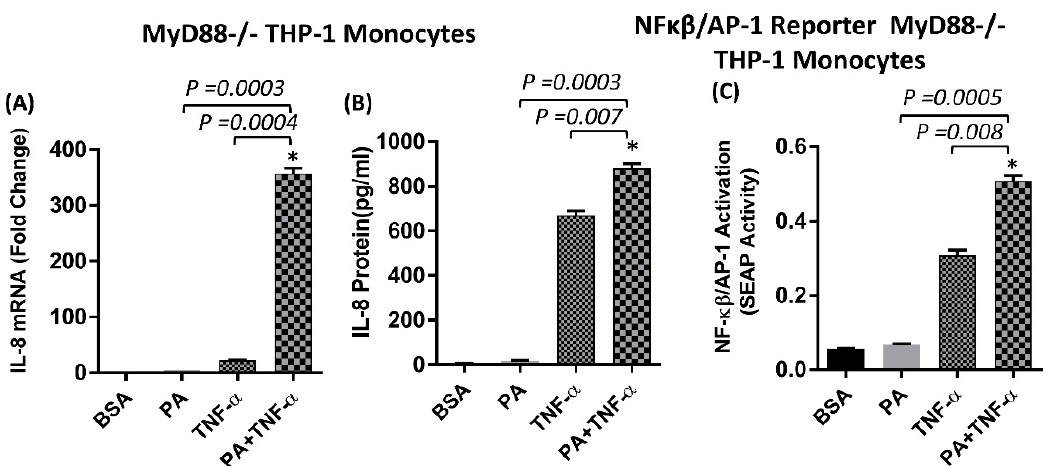
Figure 5. Synergistic induction of IL-8 by Palmitate / TNF- α involves the MyD88-independent pathway. ( A , B ) Monocytes deficient in MyD88 activity (THP-1 XBlue defMyD cells) were treated with palmitate (200 µ m), BSA (Vehicle) or TNF- α (10 ng / mL) alone or in combination for 24 h. IL-8 gene expression was determined by real-time PCR and secreted IL-8 protein was quantified in culture media by ELISA. ( C ) Cell culture media were also assayed for SEAP reporter activity representing the degree of NF- κβ /AP-1 activation. The results obtained from three replicates of each experiment are shown. All data are expressed as mean ± SEM. *Indicates significant difference.